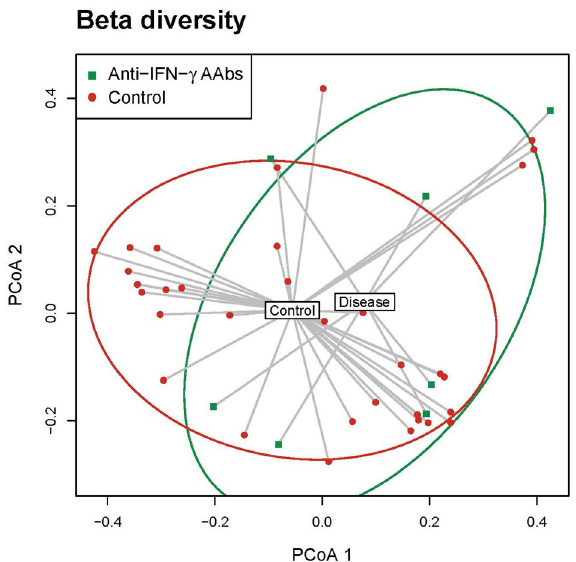
Figure 2. Beta diversity of anti-IFN-γ AAbs and HC groups. PCoA plot based on Jaccard dissimilarity of Anti-IFN-γ AAbs and HC samples using rarefied OTU matxis. Each symbol represents a sample, and the corresponding group can be found in the legend. Distances between any pair of samples represent the dissimilarities between each sample. anti-IFN-γ AAbs anti-interferon-gamma autoantibodies, HC healthy control, OTU operational taxonomic unit, PCoA principal coordinates analysis.